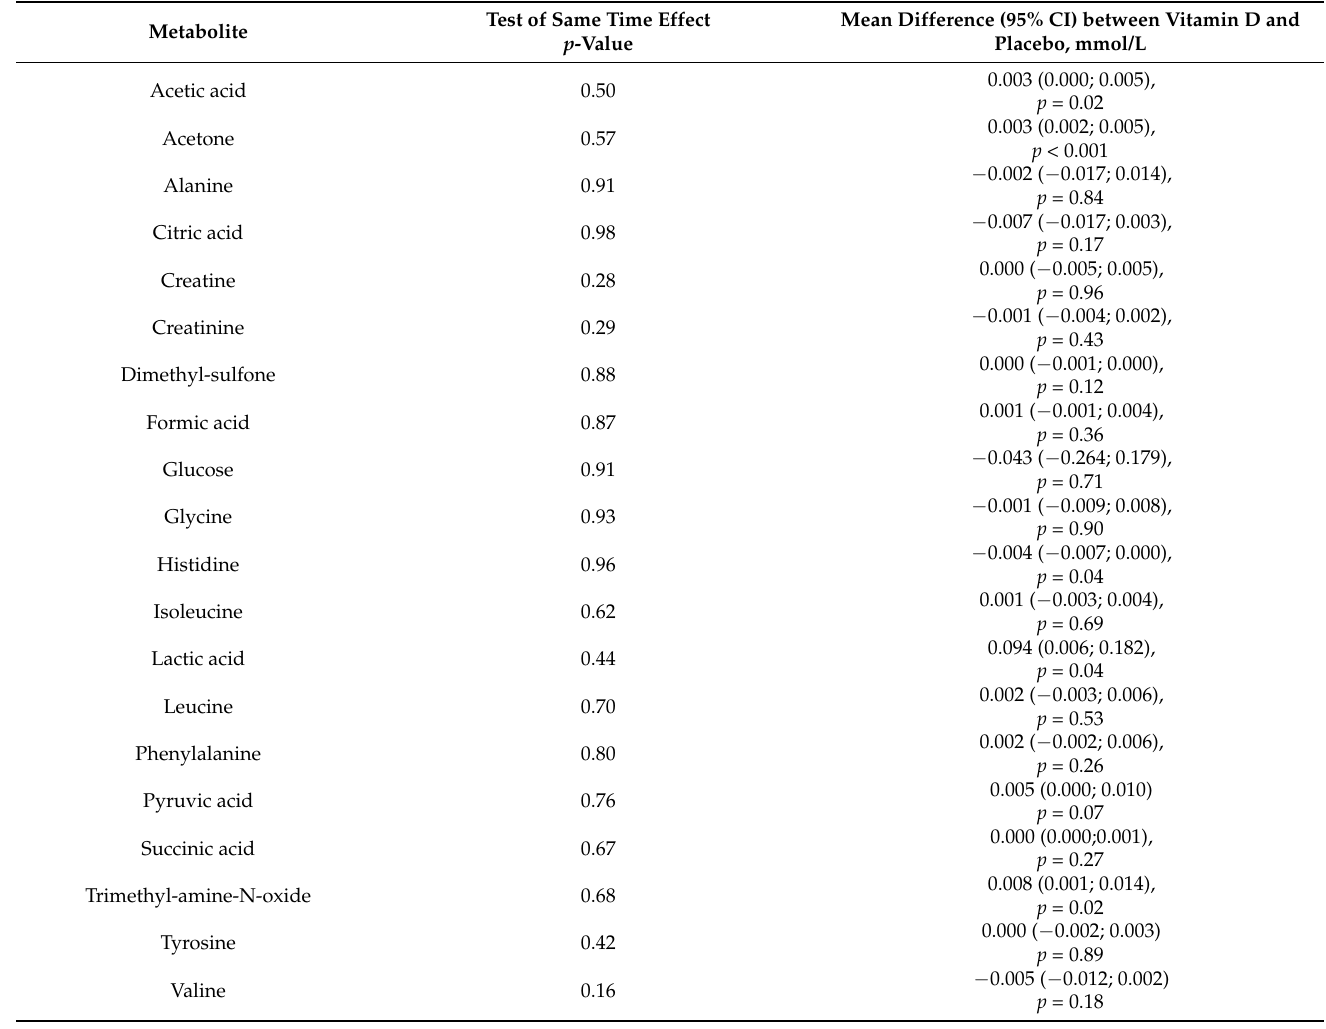
Table 2. Test for same development over time (i.e., parallel mean curves) and pairwise comparisons of mean baseline-adjusted metabolite concentrations after vitamin D supplementation and